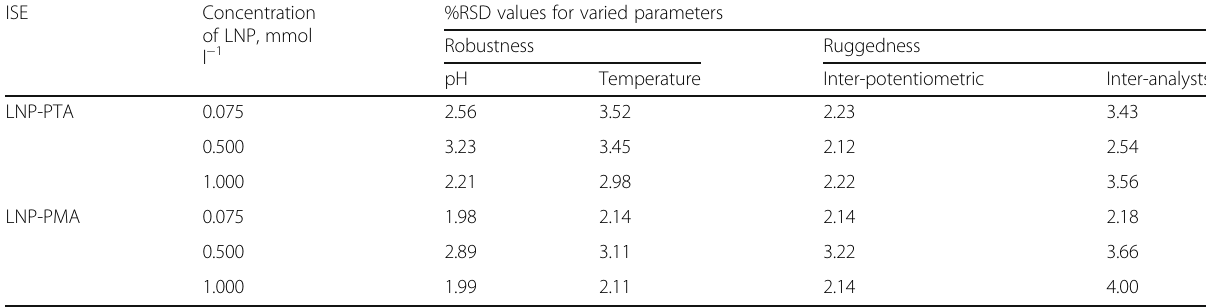
Table 5 Results of robustness and ruggedness expressed as intermediate %RSD values